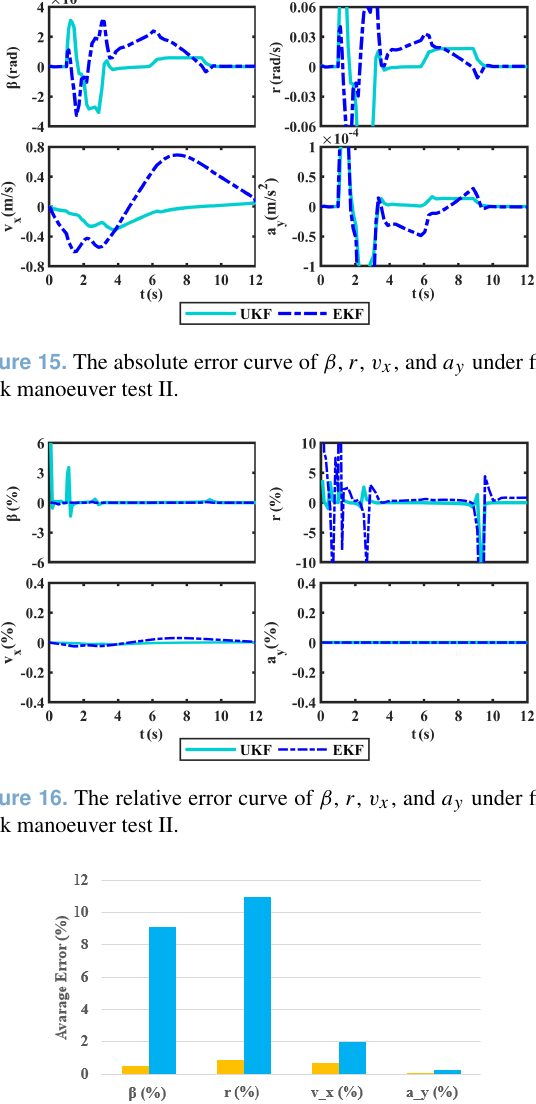
Figure 12. The relative error curve of β , r , v x , and a y under fish- hook manoeuver test I.